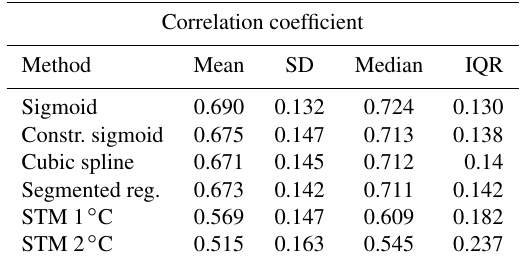
Table 2. Summary statistics of the distributions of correlation be- tween ERA5 reanalysis and predicted snow fraction. Note: IQR in- dicates the amplitude of the interquartile